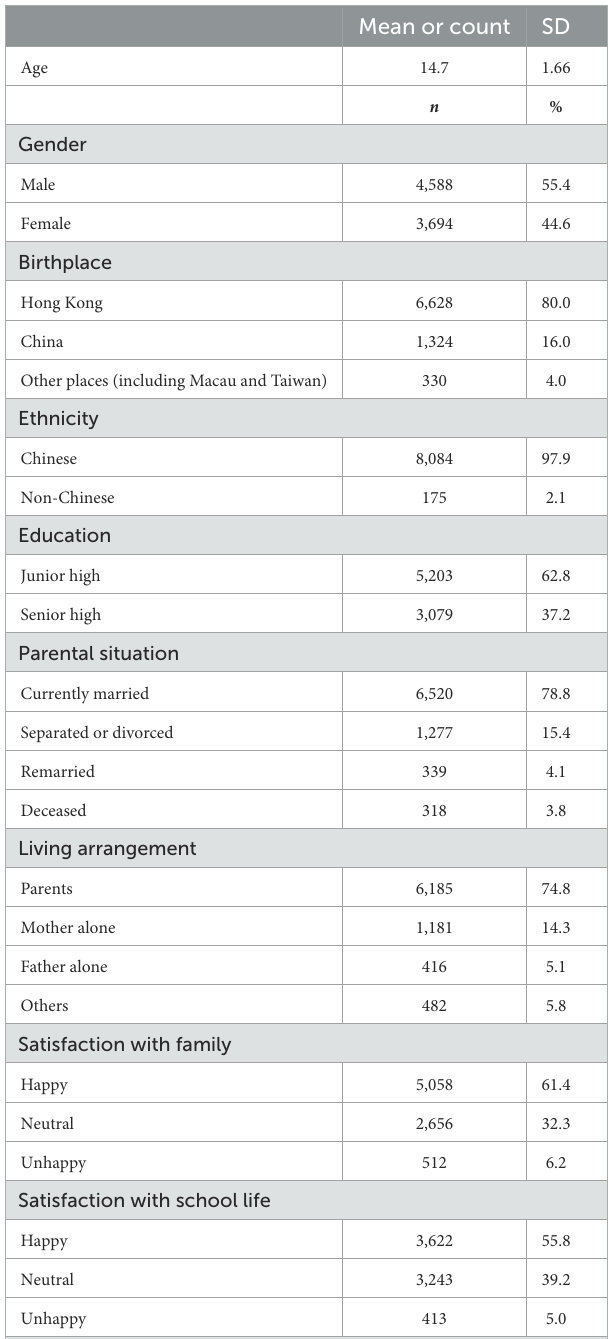
TABLE 1 Demographics, education, and family background of the